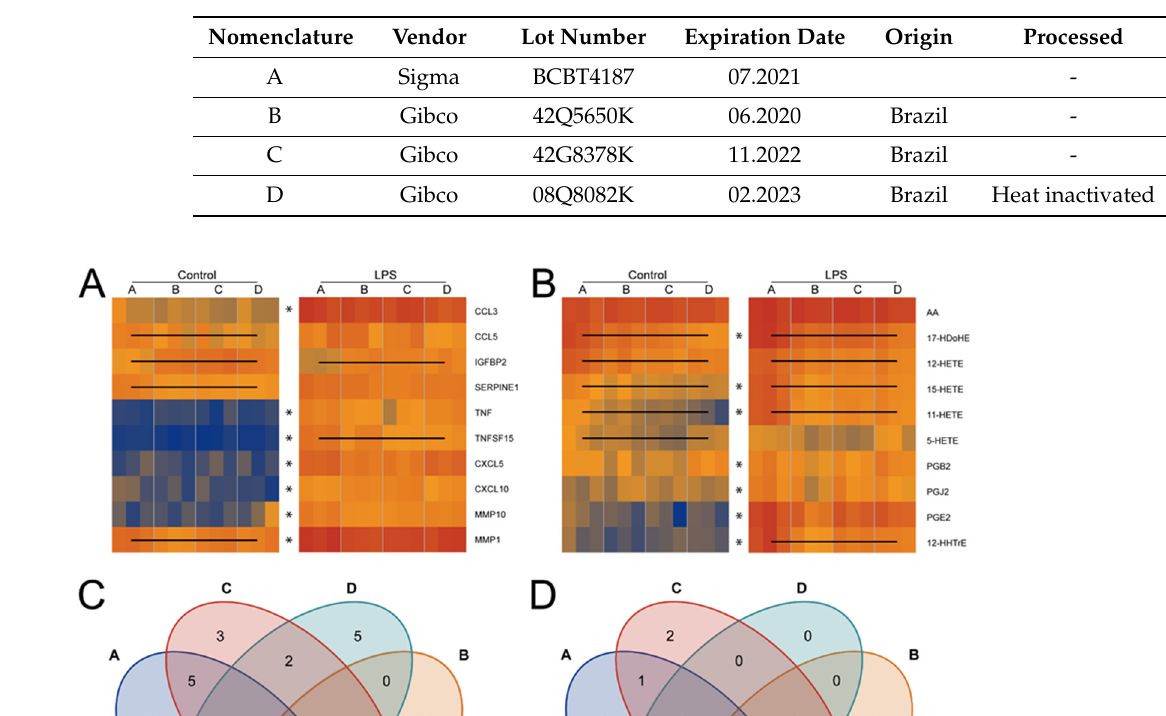
Table 1. Tested FCS batches stating Vender, Lot number, expiration date as well as letter used in this work.